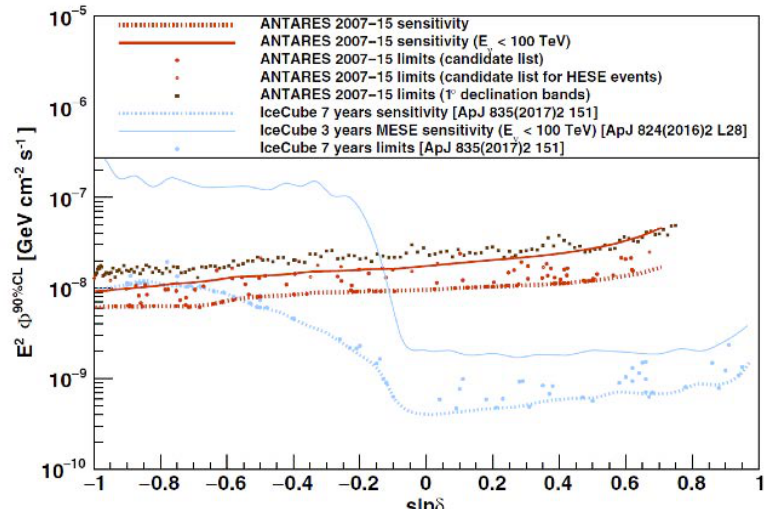
Figure 2. ANTARES (red) and IceCube (blue) sensitivities for point-like neutrino sources as a function of the declination of the source.